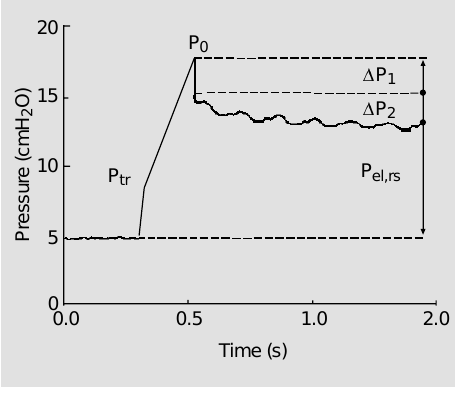
Figure 2 - Total resistance (R rsmax ) variance and subcompo- nents ( D P 1 and D P 2 ). Airway re- sistance-dependent pressure gradient ( D P 1 ) shows a signifi- cant and progressive fall along with positive end-expiratory pressure (PEEP) application from